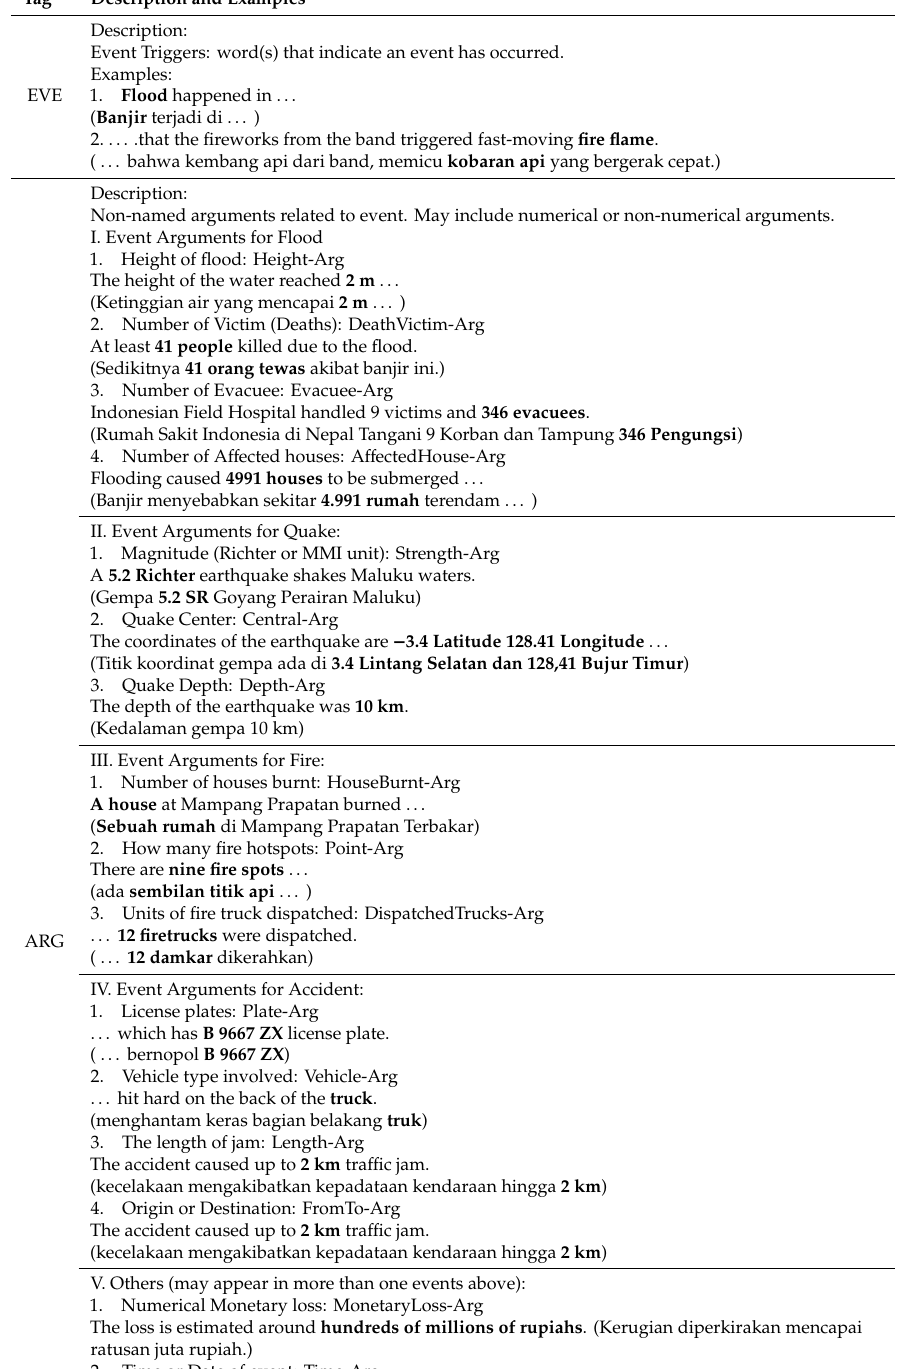
Table 2. Entity tags description. Tag Description and